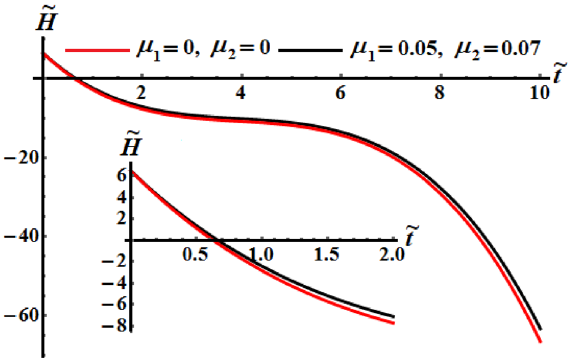
Figure 23. Portrays the evolve of ˜ H over time ˜ t at µ j = 0 ( j = 1, 2 ) , and µ 1 = 0.05, µ 2 = 0.07.